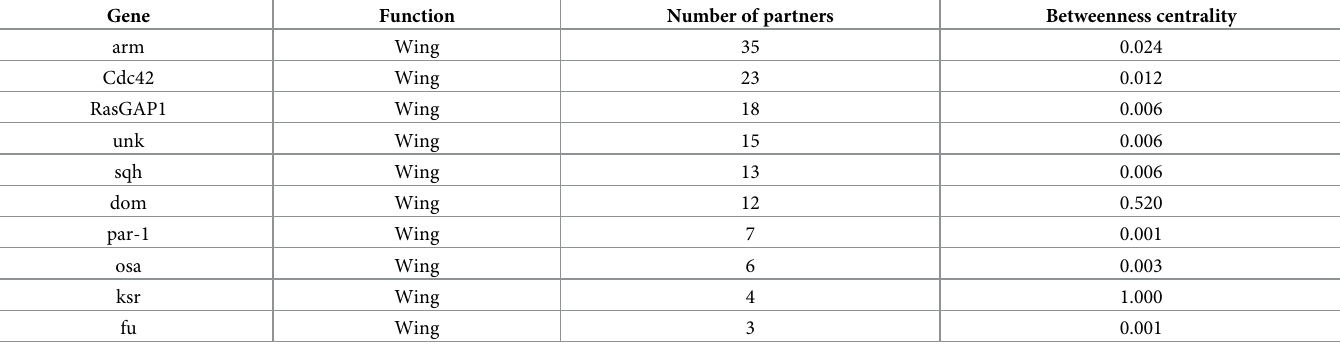
Table 4. List of genes with wing development and metamorphosis-related genes and topological network parameters (Number of interaction partner and between- ness centrality). Gene Function Number of partners Betweenness centrality Wing